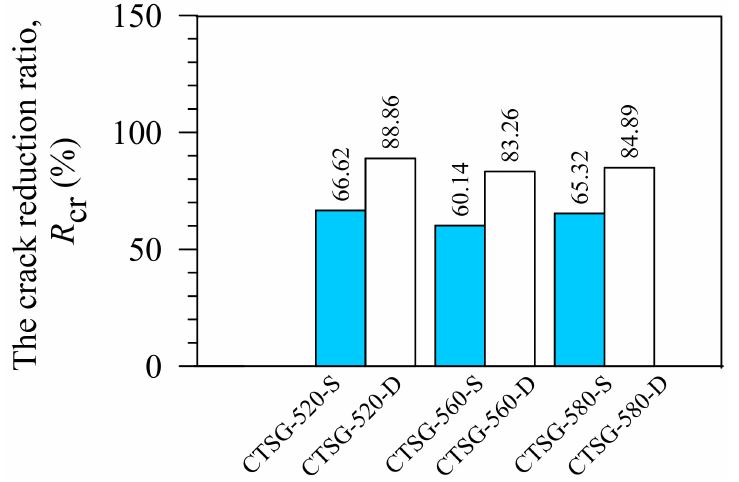
Figure 12. Crack reduction